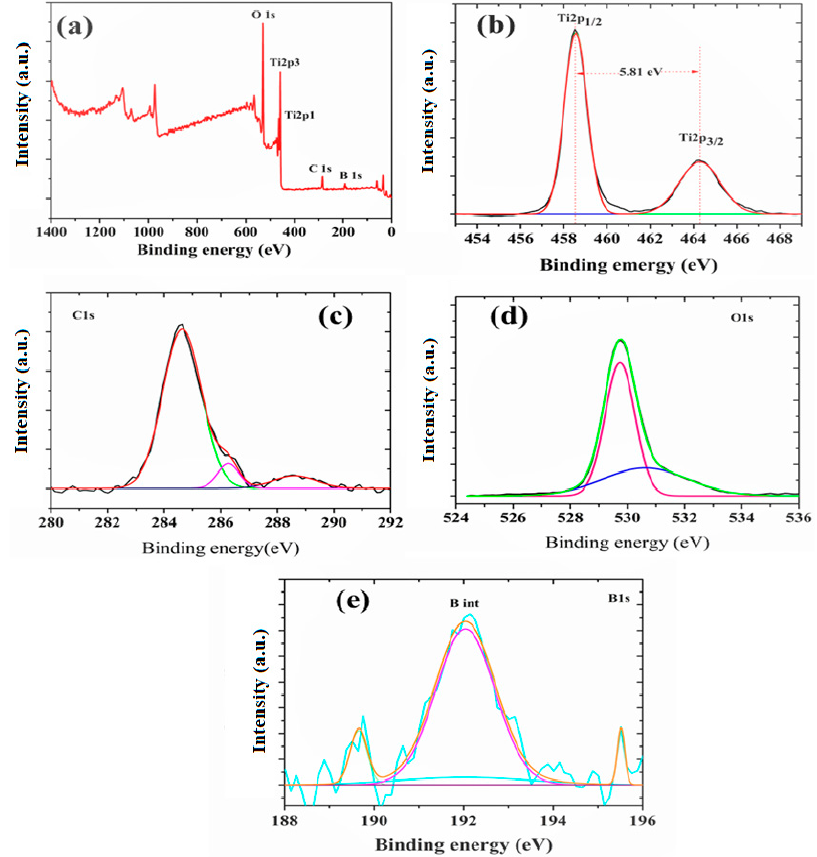
Figure 5. XPS spectra of 3B-TiO 2 -CNT nanocomposites ( a ) survey spectrum ( b ) Ti 2p, ( c ) C 1s, ( d ) O 1s and ( e ) B 1s configuration.